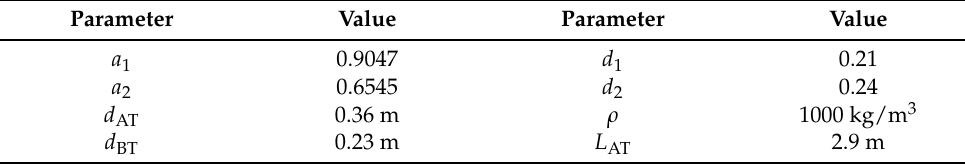
Table 2. Identified parameters of the actuators’ thrust models according to